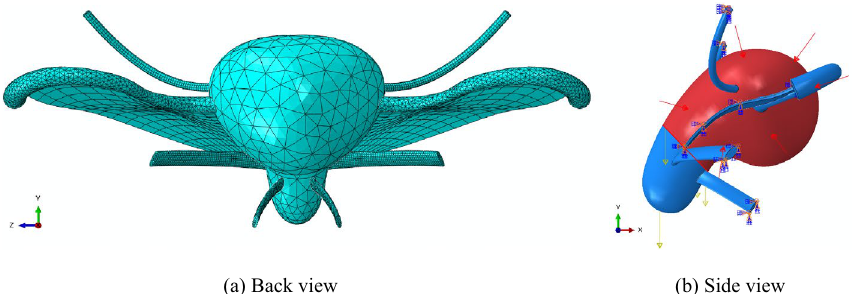
Figure 2. Finite element mesh and boundary conditions. a Back view. b Side view. (created by Abaqus 2020, https:// www. 3ds. com/ zh/ produ cts- servi ces/ simul ia/ produ cts/